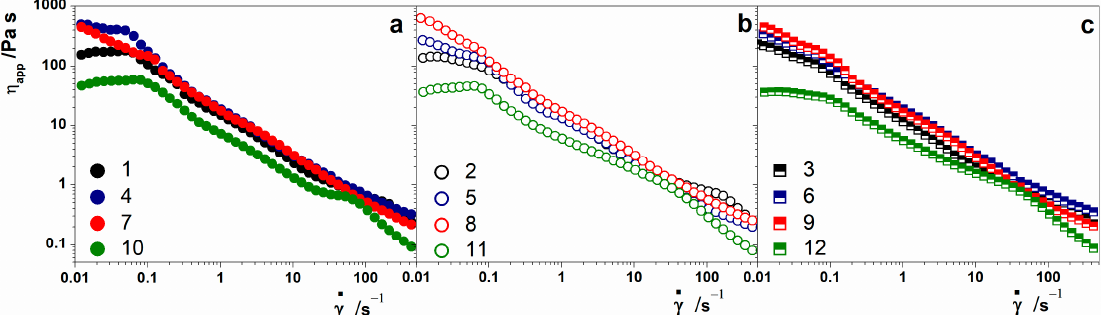
Figure 2. Shear rate dependence of the hydrogels’ shear viscosity. Black symbols indicate samples with 1 wt % of alginate and Ca 2+ 6 mM, blue symbols indicate samples with 1 wt % of alginate and Ca 2+ 8 mM, red symbols are for samples with 1 wt % of alginate and Ca 2+ 10 mM, and green symbols represent samples with 0.5 wt % of alginate and Ca 2+ 4 mM. ( a ) Hydrogels without essential oil; ( b ) hydrogels with 0.1% essential oil; ( c ) hydrogels with 0.5% essential oil.